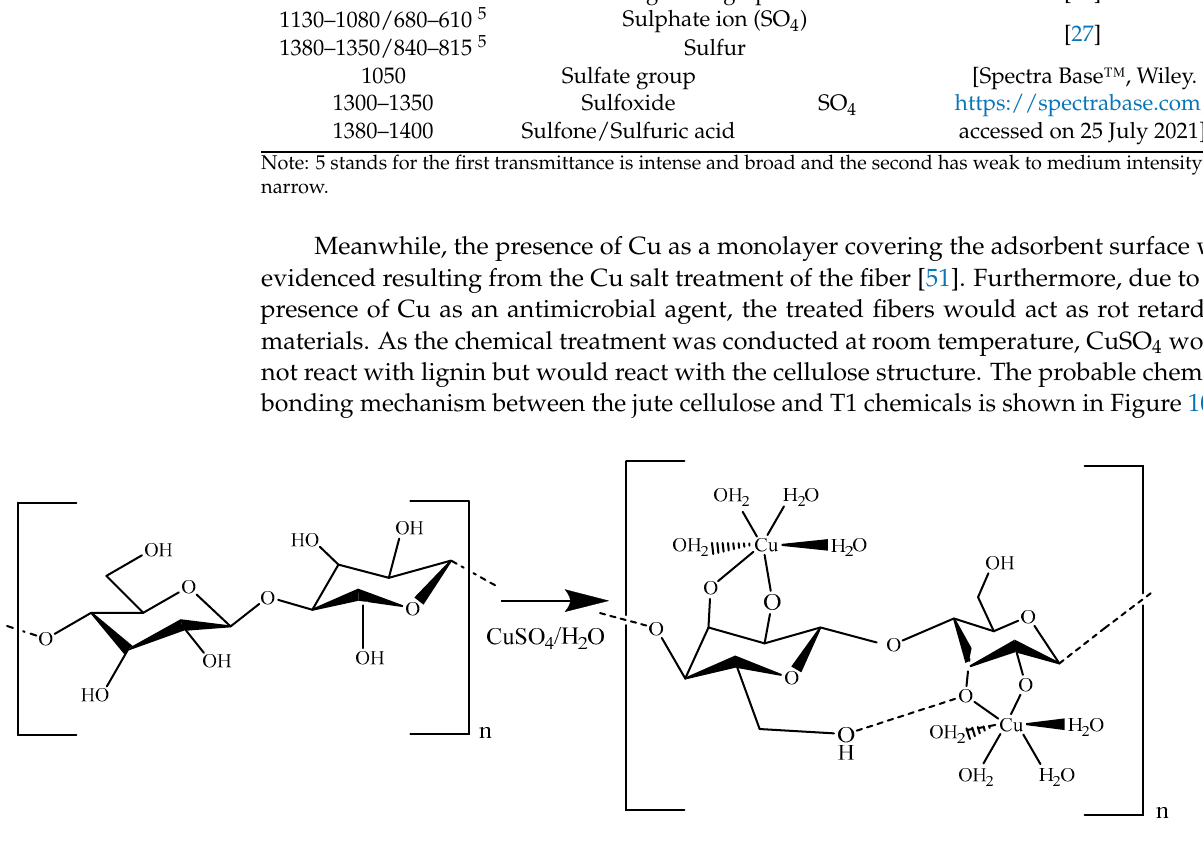
Figure 10. Possible mechanism of bond formation between CuSO 4 and jute cellulose.